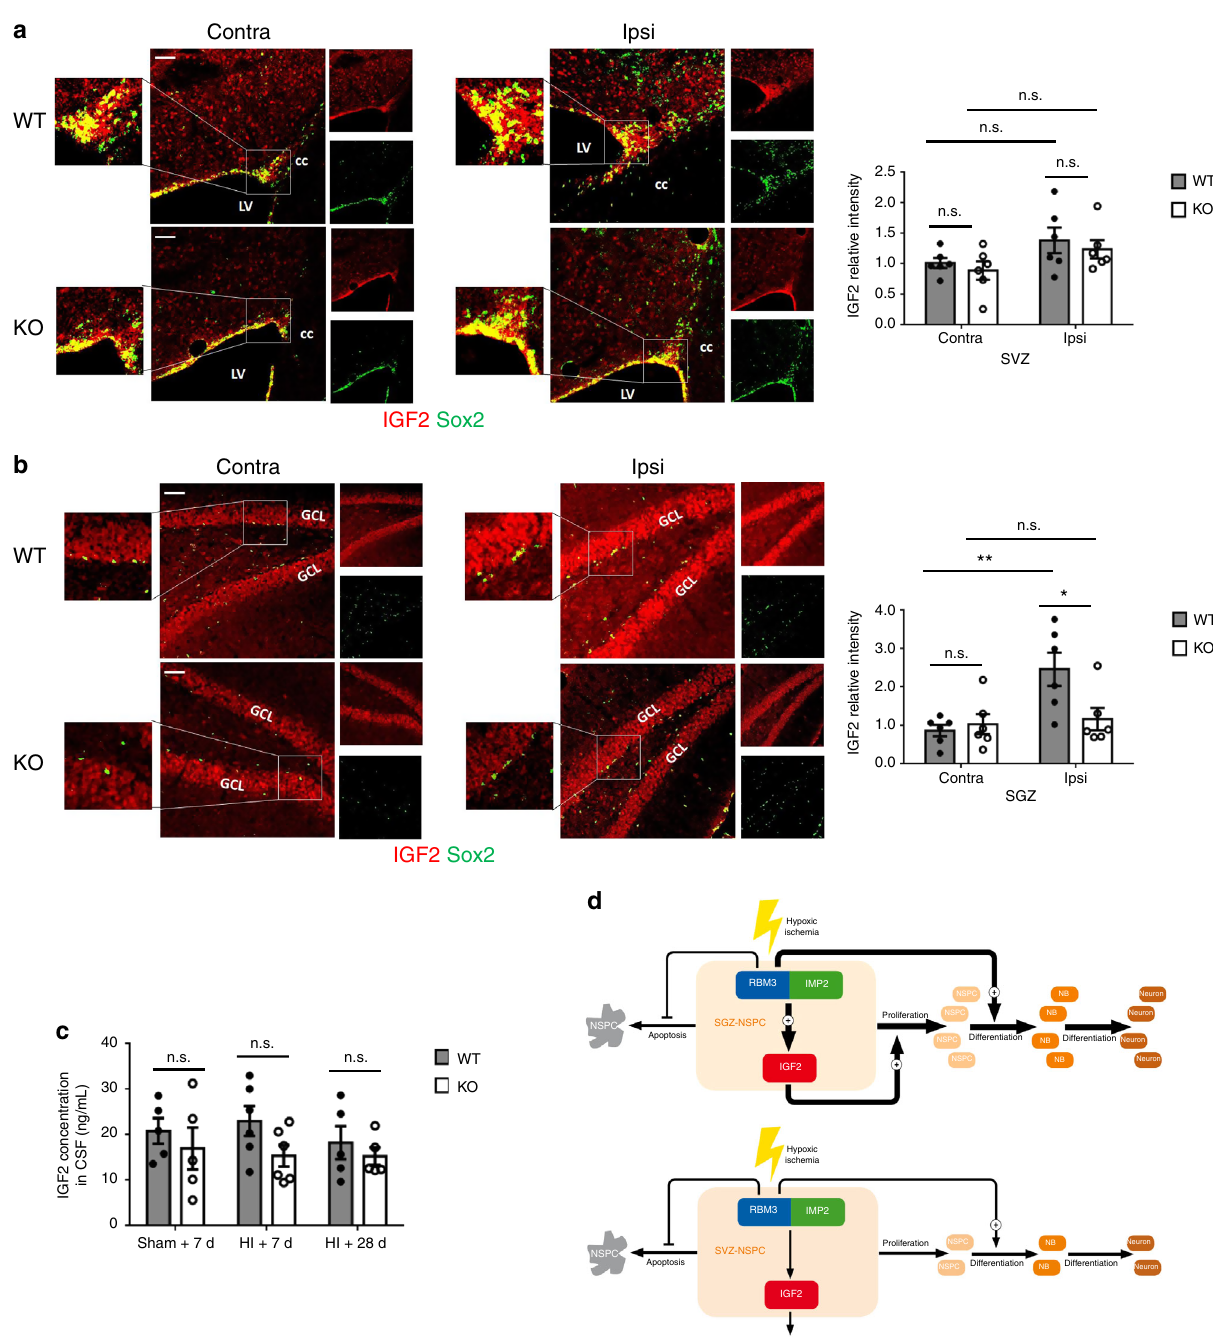
Fig. 7 RBM3 regulates IGF2 expression in SGZ but not in SVZ in vivo. a , b Representative immuno fl uorescent IGF2 staining in SVZ ( a ) or SGZ ( b ) of RBM3 WT and KO animals treated with HI and recovered for 7 days. All images were captured with the same parameters. Sox2 + NSPCs were co-stained to identify the SVZ or SGZ. Relative IGF2 intensity in indicated area was quanti fi ed with Image J. Six animals were counted per group ( n = 6). Scale bar: 50 µ m. LV lateral ventricle, cc corpus callosum, GCL granular cell layer, Contra contralateral (uninjured side), ipsi ipsilateral (injured side). Repeated measures two-way ANOVA was used for statistical analysis; n.s. not signi fi cant; * p < 0.05; ** p < 0.01. c ELISA measurement of IGF2 levels in cerebrospinal fl uid (CSF). CSF samples were collected from WT or KO mice treated with sham operation, HI plus 7 days recovery or HI plus 28 days recovery (Sham + 7d: n = 5, HI + 7d: n = 6, HI + 28d: n = 5). Two-way ANOVA was used for statistical analysis; n.s. not signi fi cant. All data are presented as mean ± SEM. d Hypothesized model. In SGZ-NSPC, RBM3 interacts with IMP2 and thereby enhances IGF2 expression and release to promote SGZ-NSPC proliferation in an autocrine pattern after HI injury. On the other hand RBM3 promotes neuronal differentiation. In SVZ-NSPC, RBM3 does not promote proliferation after HI injury and affects neuronal differentiation to a lesser extent. In both cell types, RBM3 inhibits apoptosis. NB